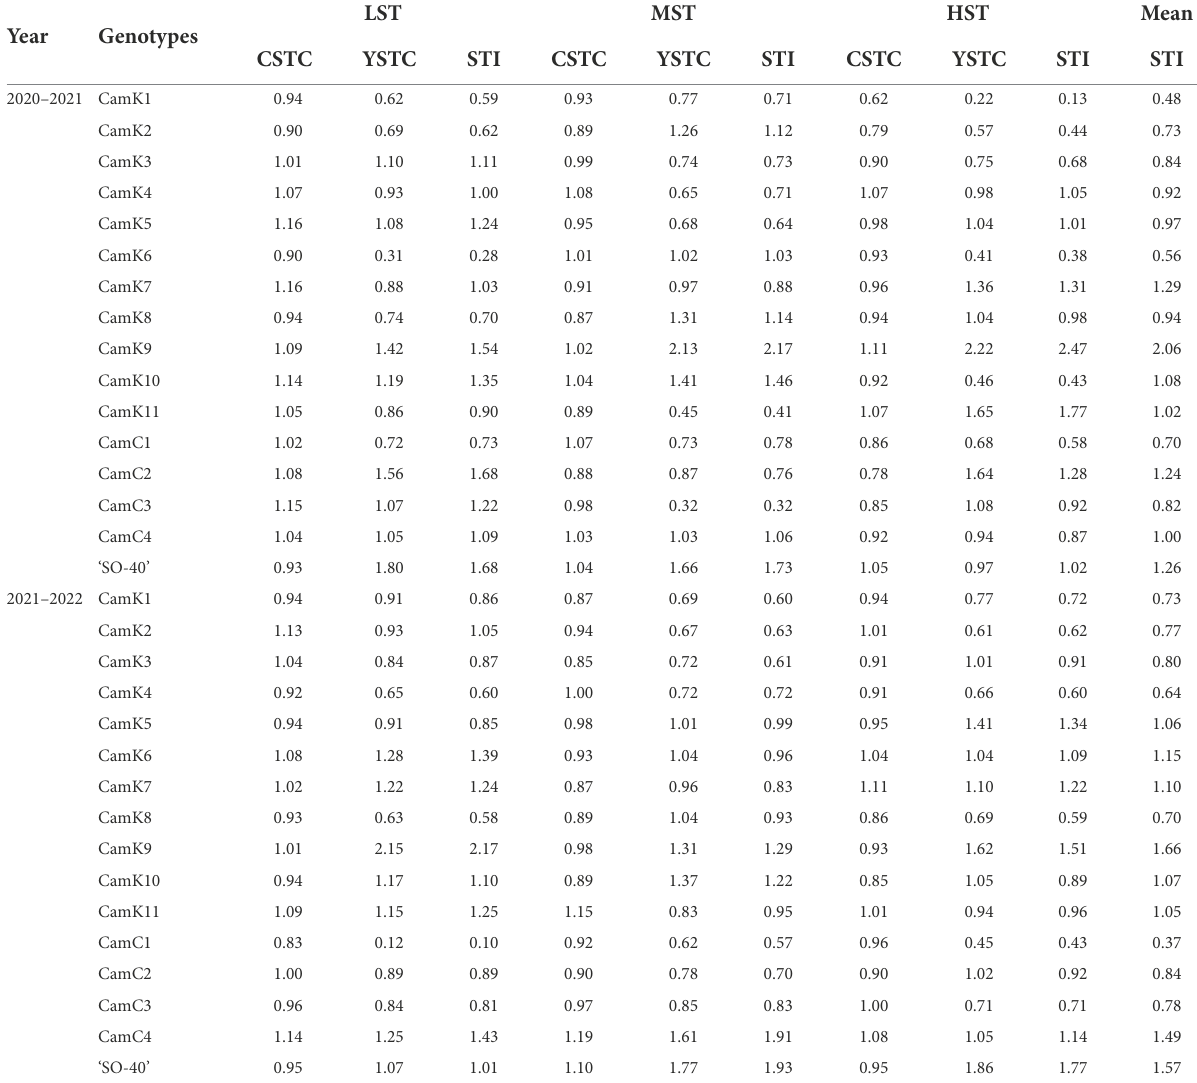
TABLE 4 Comprehensive shade tolerance coefficient (CSTC), seed yield shade tolerance coefficient (YSTC), and shade tolerance index (STI) of camelina genotypes under low shade treatment (LST), medium shade treatment (MST), and high shade treatment (HST) in 2020–2021 and 2021–